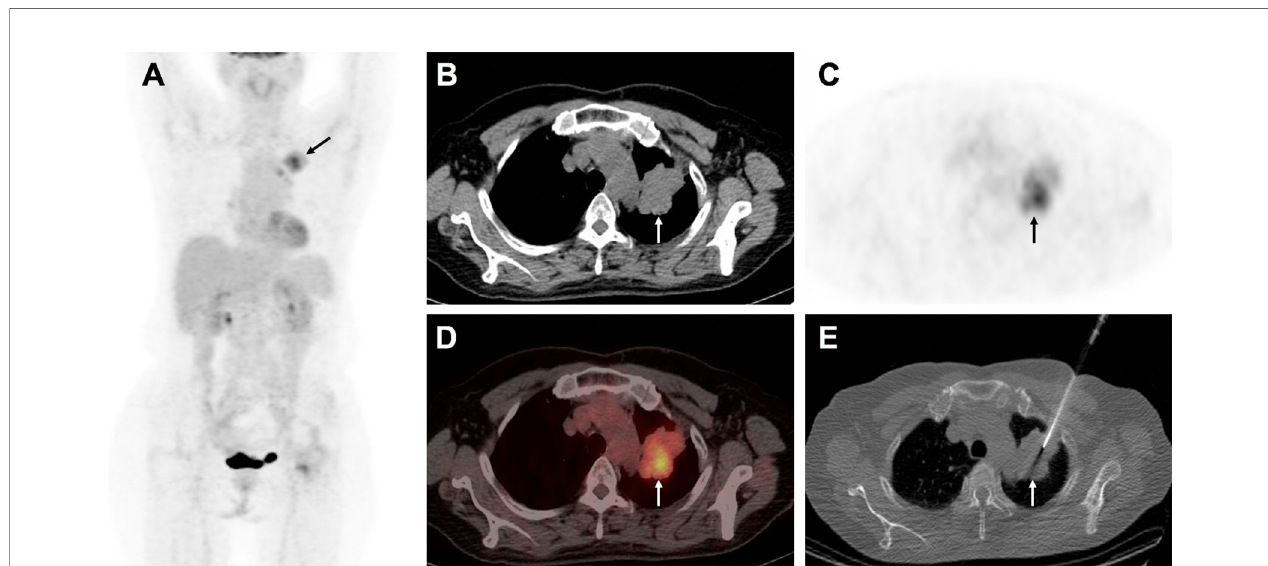
FIGURE 4 | A 58-year-old man with suspected lung carcinoma underwent 18 F-FDG PET/CT for tumor staging before treatment. The maximum intensity projection image (A) shows intense activity in the left upper lobe of the lung (arrow). Axial view of PET/CT (B) CT scan, (C) PET image, (D) , combined PET/CT image, shows the metabolic active mass (arrow) with atelectasis in its caudal part. Axial view of CT image (E) shows biopsy needle positioned into the metabolic active area (arrow). Histological examination con fi rmed the lung lesion as primary